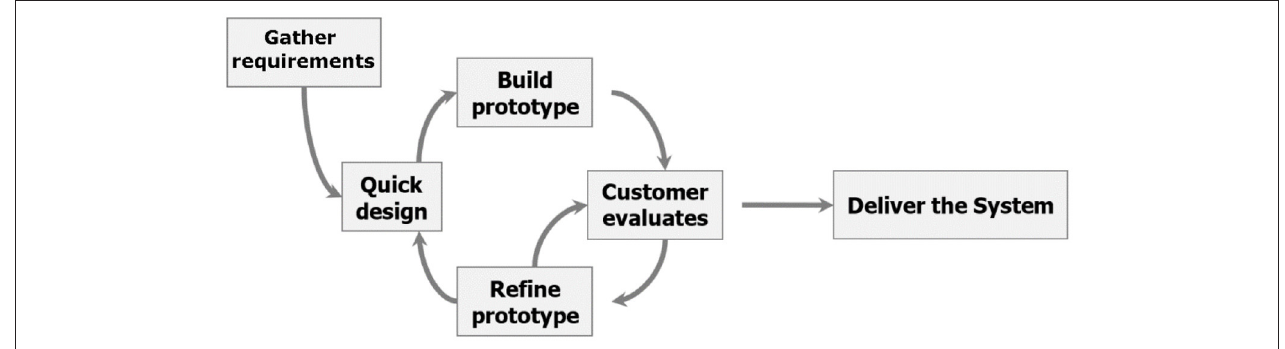
FIGURE 3 | Evolutionary prototyping